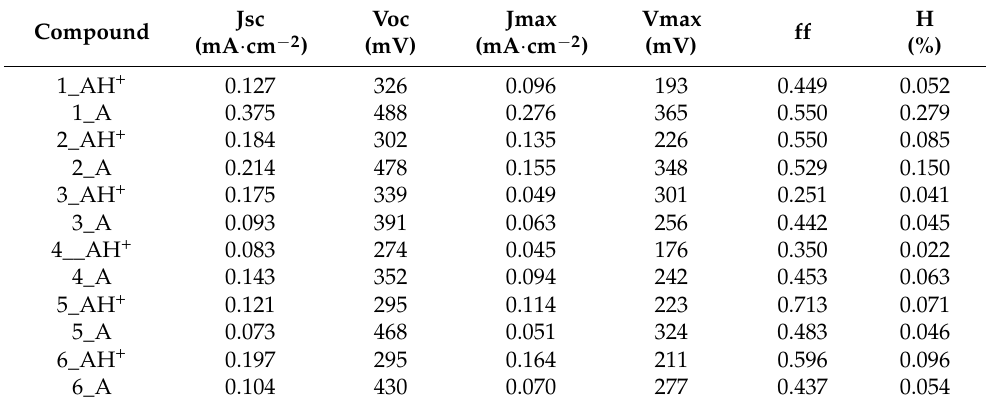
Table 7. The photovoltaic parameters of the DSSCs based on the flavylium dyes. Jsc Compound (mA · cm − 2 )